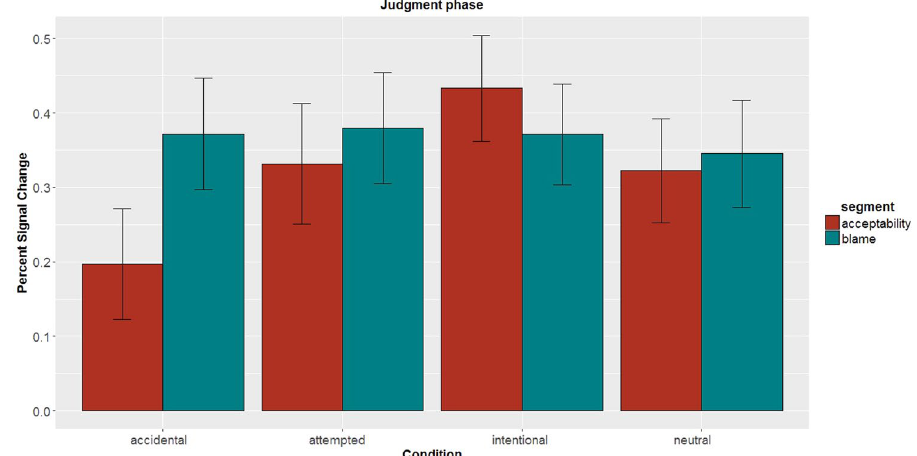
Figure 10. The empathy network activity during the judgment phase. The estimated PSC across all ROIs of the empathy network during the judgment phase, i.e. when the participants made two types of moral judgments. The PSC was higher for blame as compared to acceptability judgments only for accidental harm scenarios ( p < 0.001). Error bars correspond to 95% confidence intervals. Abbreviations –PSC: percent signal change, ROI: region of